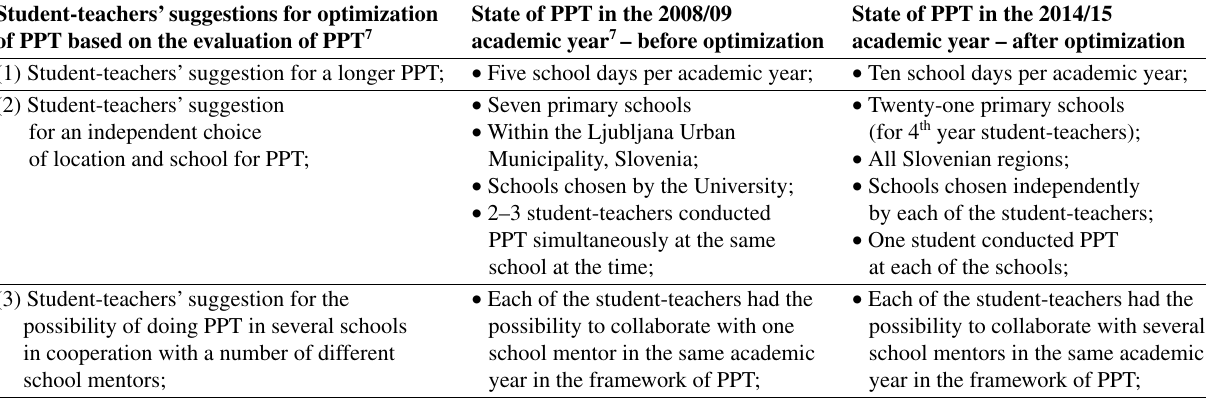
Table 1 . Changes that have been introduced in PPT with regard to student-teachers’suggestions Student-teachers’ suggestions for